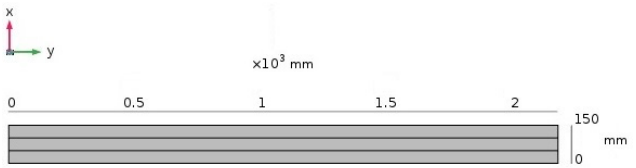
Figure 2. Bottom view of a photovoltaic panel.